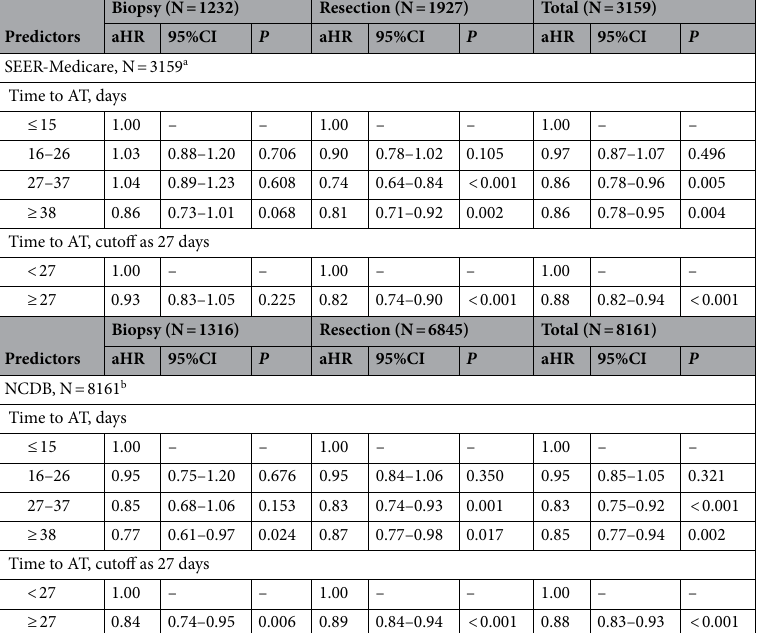
Table 4. Multivariable Cox models of OS in relation to time to AT from SEER-Medicare and NCDB a,b . AT adjuvant therapy, HR hazard ratio, 95% CI 95% confidence interval. a Adjusted time to AT, age at diagnosis, gender, period, race/ethnicity, marital status, residence, education, income, registry location, surgery, AT, and Charlson Comorbidity Score by using multivariable Cox proportional models in SEER-Medicare. b Adjusted time to AT, age at diagnosis, gender, period, race/ethnicity, residence, education, income, insurance, facility location, distance, care transition, surgery, AT, and Charlson/Deyo score by using multivariable Cox proportional models in